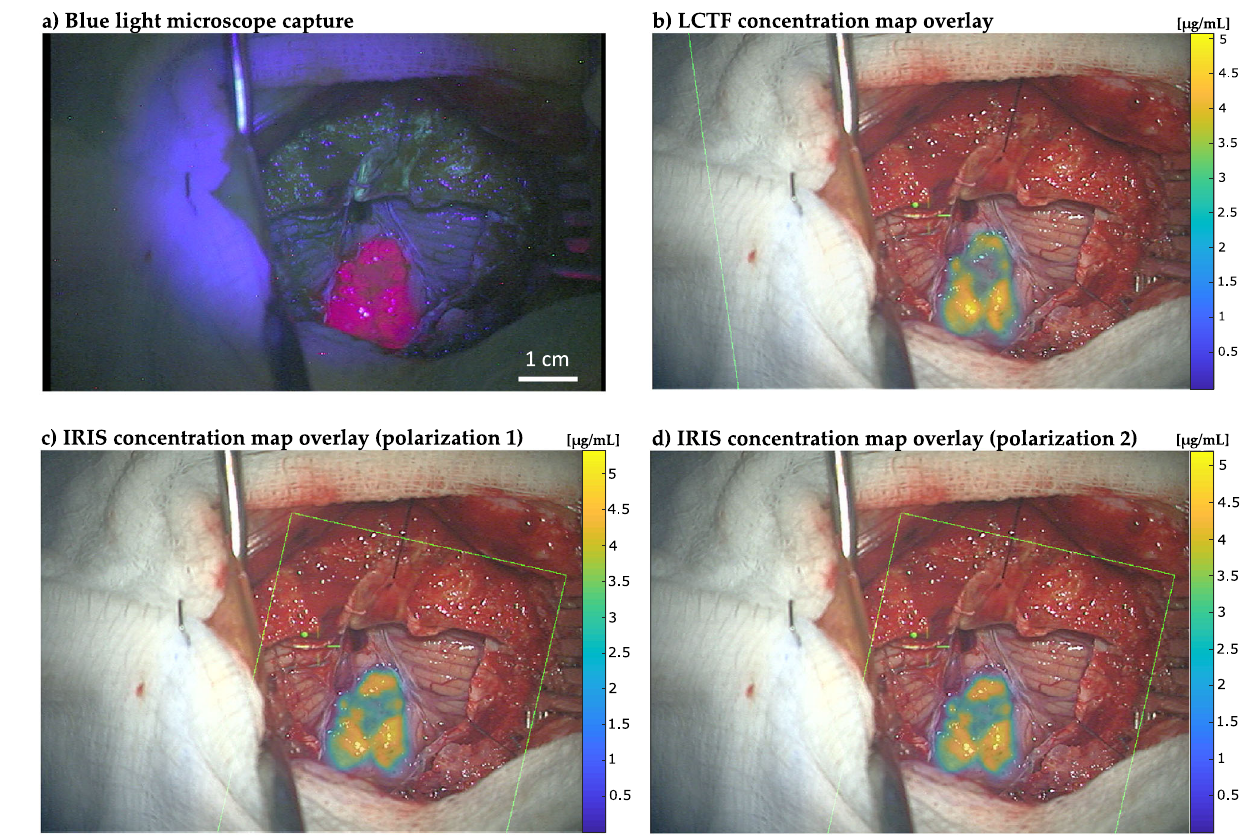
Fig. 4 Comparison of visual PpIX fl uorescence and quantitative concentration maps imaged during neurosurgery. a Visible fl uorescence of PpIX illuminated under blue light. b PpIX concentration map generated from hyperspectral data acquired with the LCTF. c PpIX concentration map generated with IRIS using channels from the 1 st polarization. d PpIX concentration map generated with IRIS using channels from the 2 nd polarization. Concentration maps are overlaid on RGB images of the surgical fi eld of view acquired with the Pentero operating microscope. Green box represents the fi eld of view of the hyperspectral imaging system used to detect fl uorescence. Color scale bars show imaged PpIX concentrations in micrograms per milliliter ( μ g/mL). Spatial scale bar (1 cm) appears in a